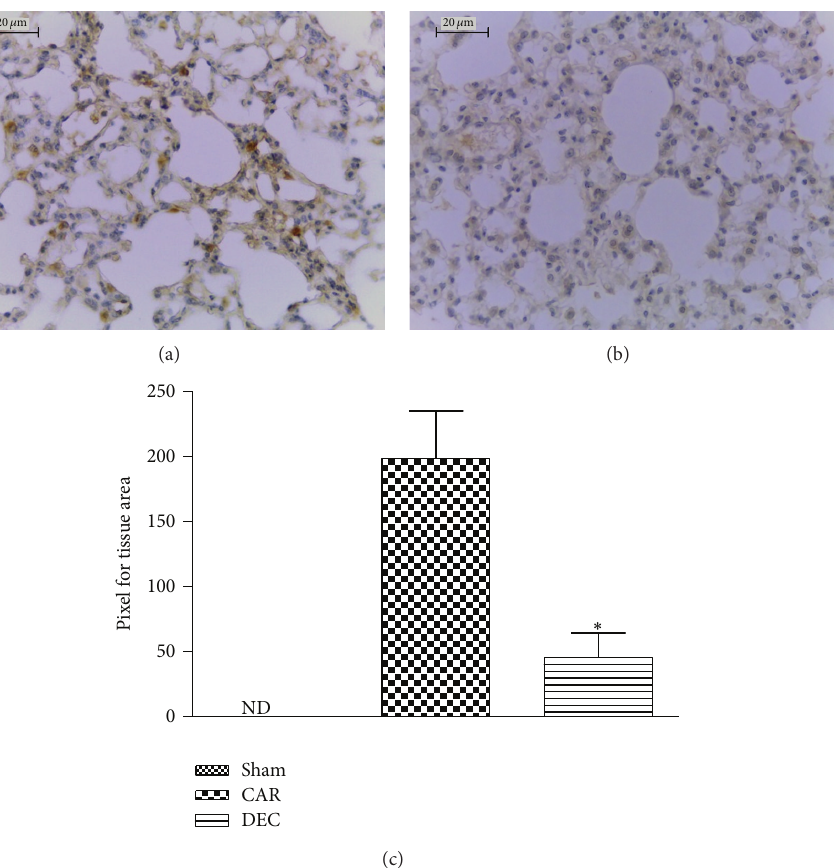
Figure 6: Effects of DEC on immunohistochemical localization of IL-1 𝛽 . (a) At 4h after carrageenan injection, staining intensity for IL-1 𝛽 substantially increased in alveolar macrophages. (b) No positive staining for IL-1 was found when DEC was administered three days prior to carrageenan injection. (c) Densitometry analysis of immunohistochemistry photographs for IL-1- 𝛽 in lung tissues; figure representative of at least 3 experiments performed on different experimental days; data expressed as mean ± S.E.M. from 𝑛 = 5 mice for each group; ND: not detected; ∗ 𝑃 < 0.05 versus carrageenan; scale bar = 20 𝜇